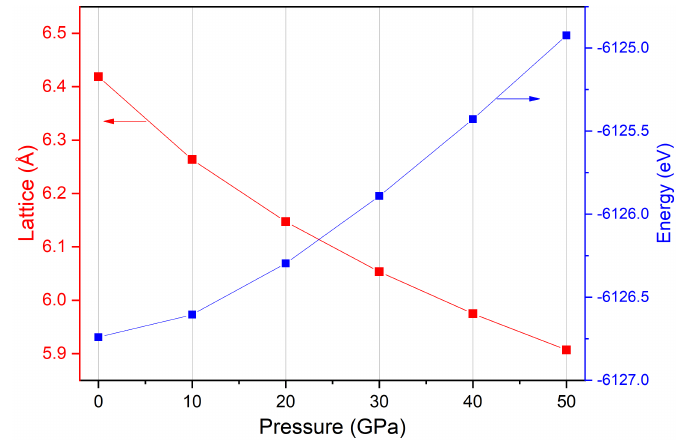
Figure 2. The calculated lattice constant and total energy of Ti 2 NiIn compound under different external pressure. 0 GPa refers to the equilibrium